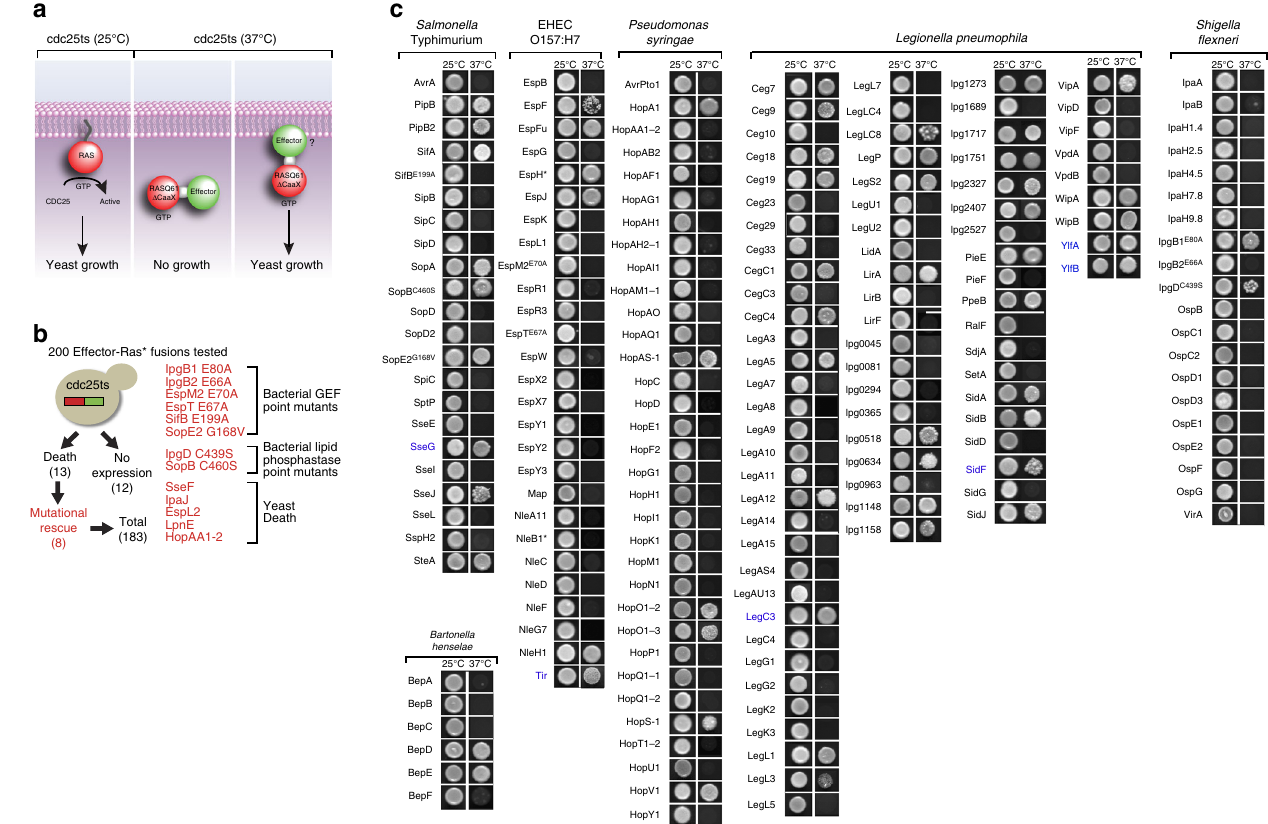
Fig. 1 The Ras-rescue screen. a Schematic diagram of the temperature-sensitive Ras-rescue system used to identify membrane-associated effectors in yeast. b Experimental setup for construction of the Ras*-effector fusion library and mutants that alleviated yeast growth inhibition. Ras*-effector-HA fusion proteins (labeled red-green ) were expressed in cdc25ts and assayed for growth inhibition. Catalytically dead mutations (if known) were made in each effector that caused yeast growth defects, allowing for those effectors to be included in the screen. The catalytic residues for EspL2 Ec , LpnE Lp , SseF St , IpaJ Sf , and HopAA1-2 Ps were unknown and, therefore, these effectors could not be included in the screen. c Growth assay for the cdc25ts yeast strain harboring the indicated effector genes grown at the non-restrictive temperature (25 °C) or the restrictive temperature (37 °C). Effectors that allow for yeast growth at the restrictive temperature reconstituted Ras* localization to the membrane. Effectors known to have transmembrane domains are colored in blue as con fi rmation of the